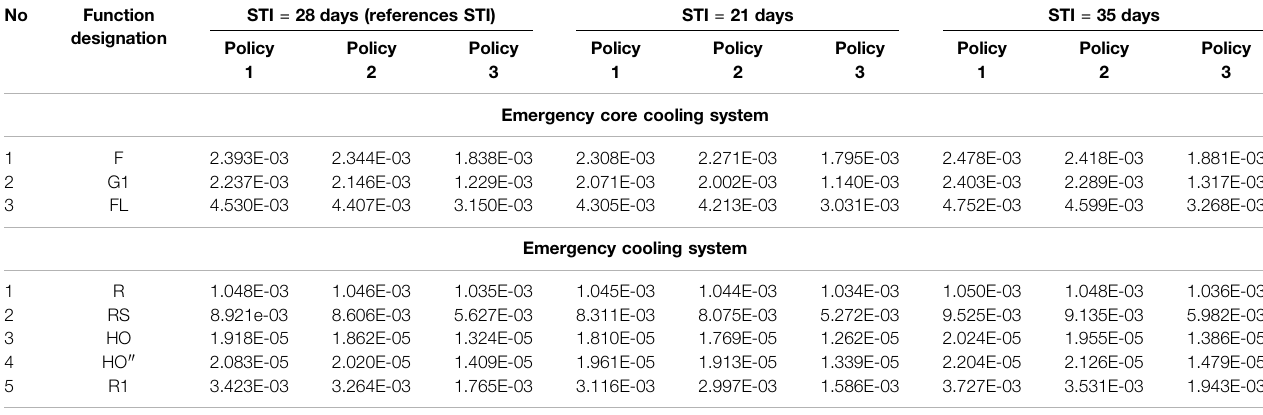
TABLE 7 | Comparison of unavailability calculated by coupling MMMs with FT method for different STIs and various system functions.